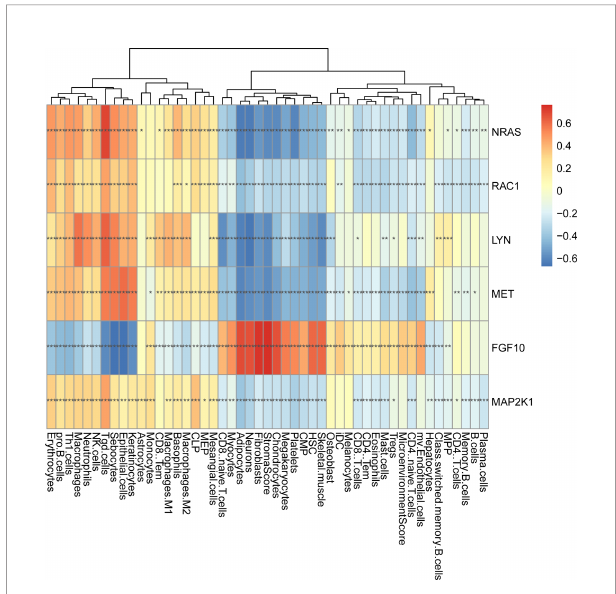
FIGURE 10 | The correlation analysis between six core immune-related mRNAs and immune cells in GC. * p < 0.05; ** p < 0.01; *** p <